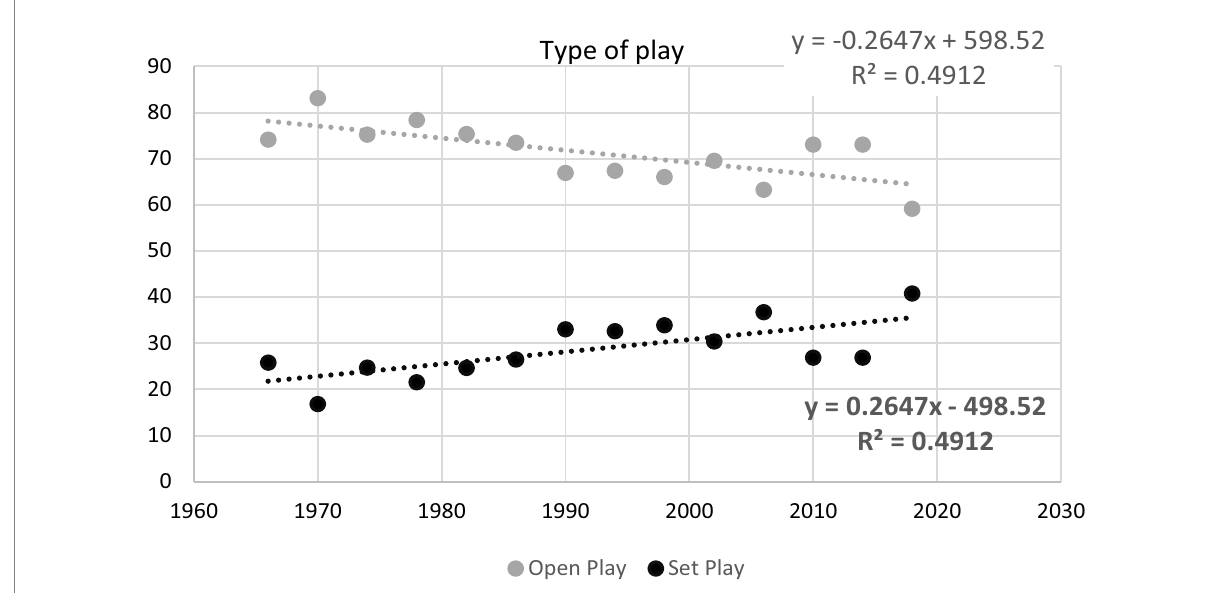
FIGURE 1 Regression analysis of the frequency of the different types of play (open and set play) through the 14 FIFA World Cups.